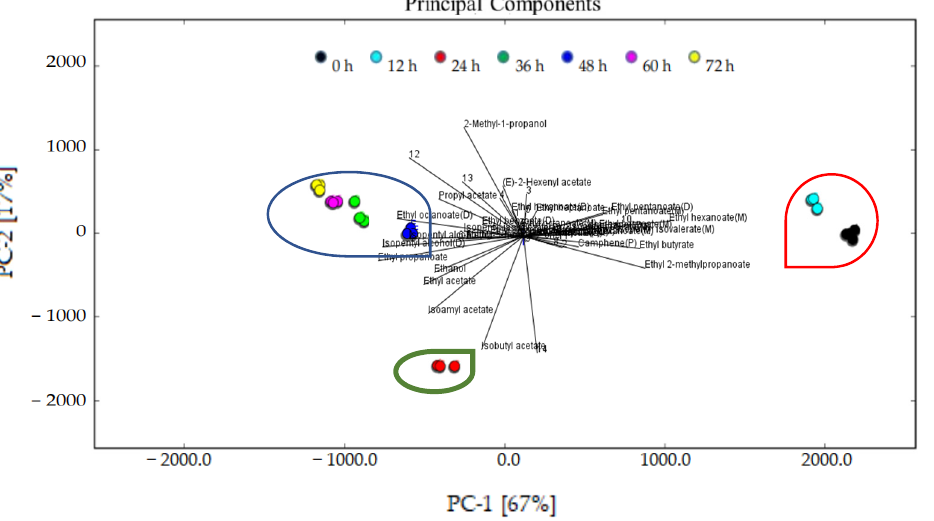
Figure 7. PCA analysis of the characteristic flavor compounds presented in the sea buckthorn juice during fermentation. during